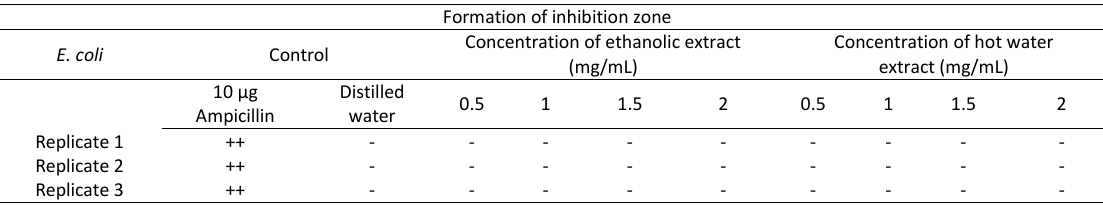
Fig. 2: Ferric reducing power of Kappaphycus alvarezii ethanolic and hot water extract Table 3: Inhibition zone of E. coli